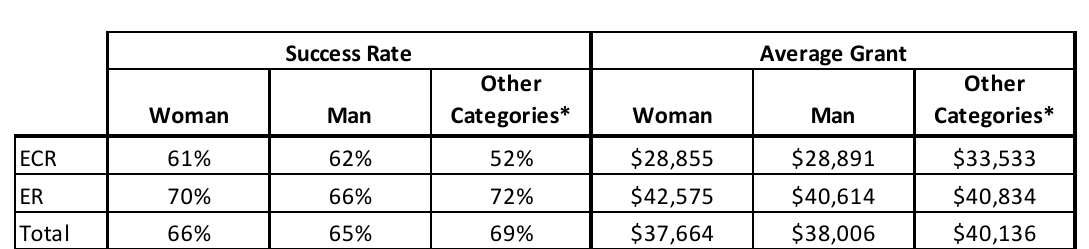
Discovery Grant Success Rate and Average Grant by